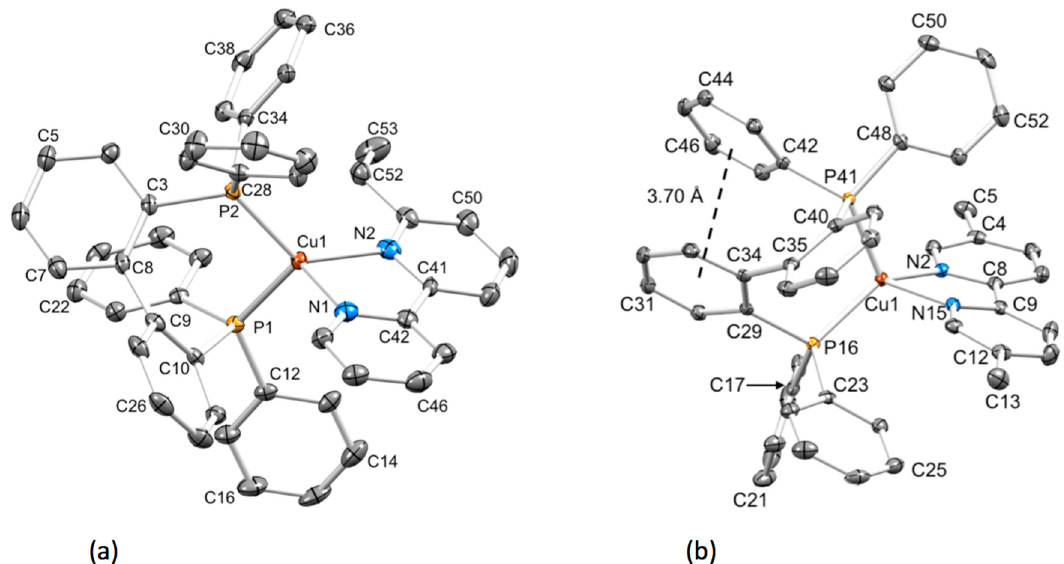
Figure 6. Structures of ( a ) the [Cu(BIPHEP)(6-Etbpy)] + cation in [Cu(BIPHEP)(6-Etbpy)][PF 6 ] and ( b ) the [Cu(BIPHEP)(5,5'-Me 2 bpy)] + cation in [Cu(BIPHEP)(5,5'-Me 2 bpy)][PF 6 ] ∙ CH 2 Cl 2 . Ellipsoids are plotted at 40% probability in ( a ) and 50% in ( b ); H atoms are omitted for clarity. For the π -stacking interaction shown in ( b ), the angle between the ring planes is 18.0° and the centroid...centroid distance is 3.70 Å.